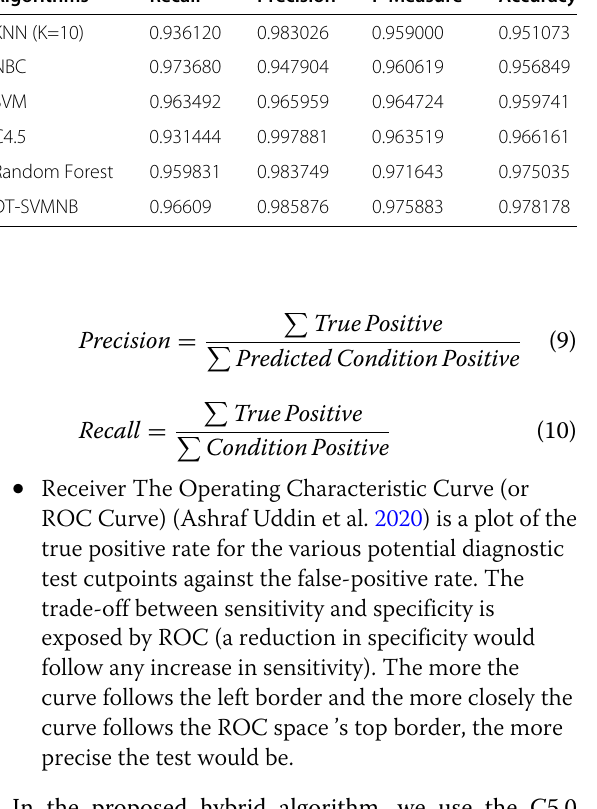
Table 4 Accuracy Comparison for Anomalous User Detection on Dataset1 Algorithms